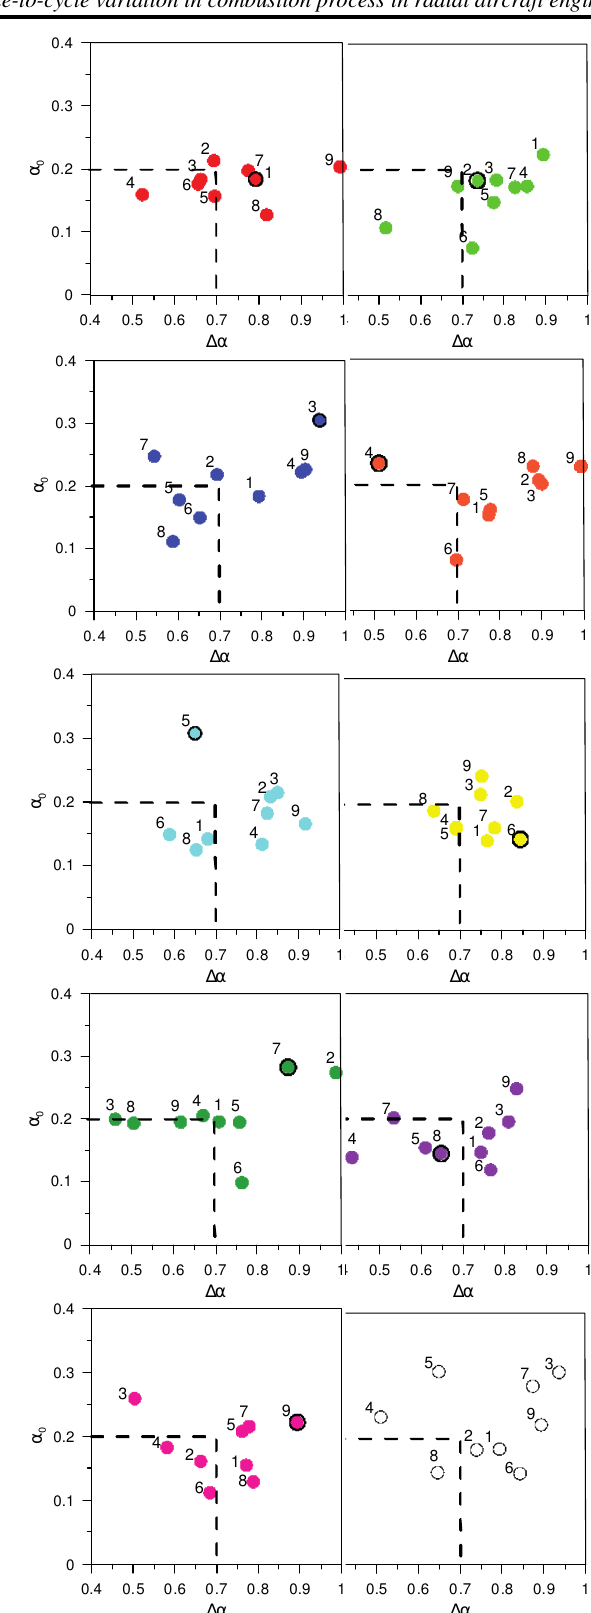
Fig. 9. Results of our MF analysis of the indicated pressure in each cylin- der supplied by a mixture of modified composition (black circle), the other cylinders supplied by a mixture of λ = 0.7. The last graph (black points) summarizes the MF analysis for the disturbed cylinders